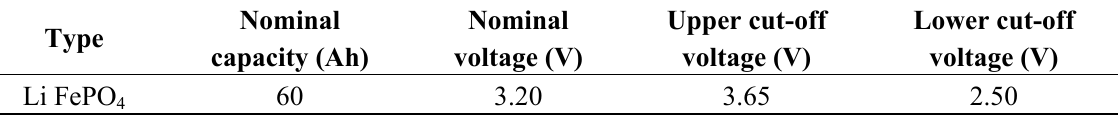
Table 2. Main specifications of the test cells.